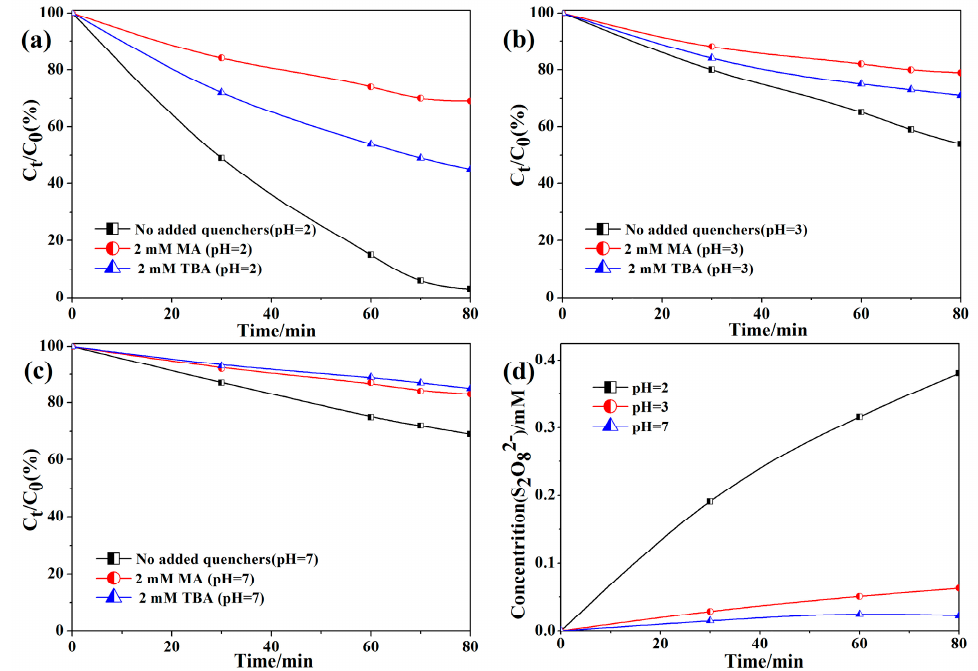
Figure 4. Removal of methyl orange with time and different additives to a 1.0 M Na 2 SO 4 aqueous solution at ( a ) pH = 2. ( b ) pH = 3 and ( c ) pH = 7. The initial conditions: MO 5 mg L − 1 , Na 2 SO 4 1 M, applied 1.5 V vs. CE. ( d ) The concentration of S 2 O 82 − with the function of time at different pH values (involving 40 mL of 1 M Na 2 SO 4 aqueous solution).